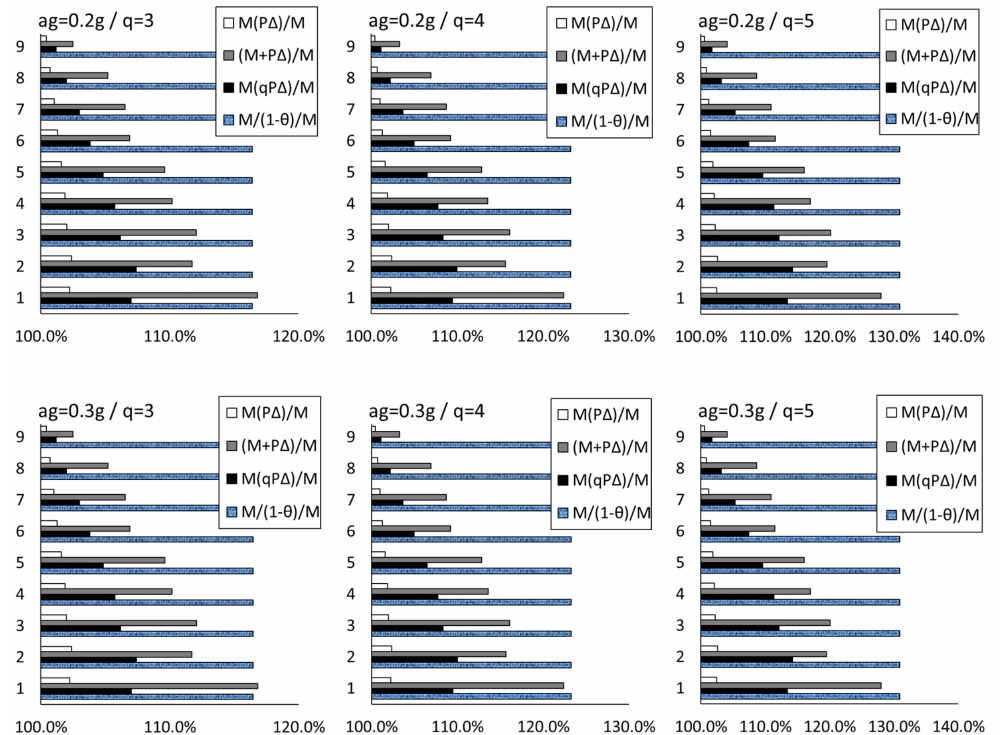
Figure 10. Influence of the q factor and ground acceleration in the P - ∆ e ff ect of nine-story steel resisting frame structure. Illustration of di ff erent approaches for the estimation of the maximum acting moment in the story